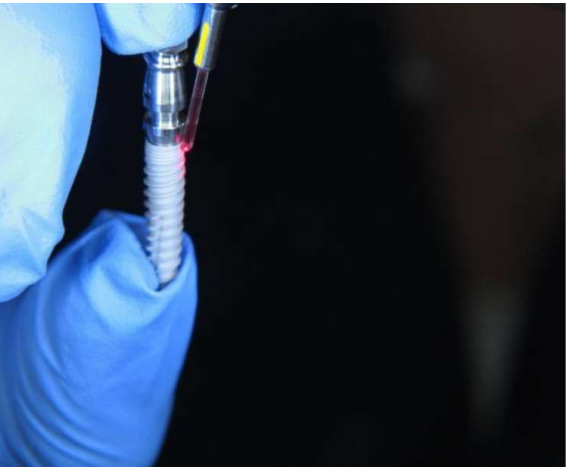
Figure 3. Laser treatment of the implant surface.